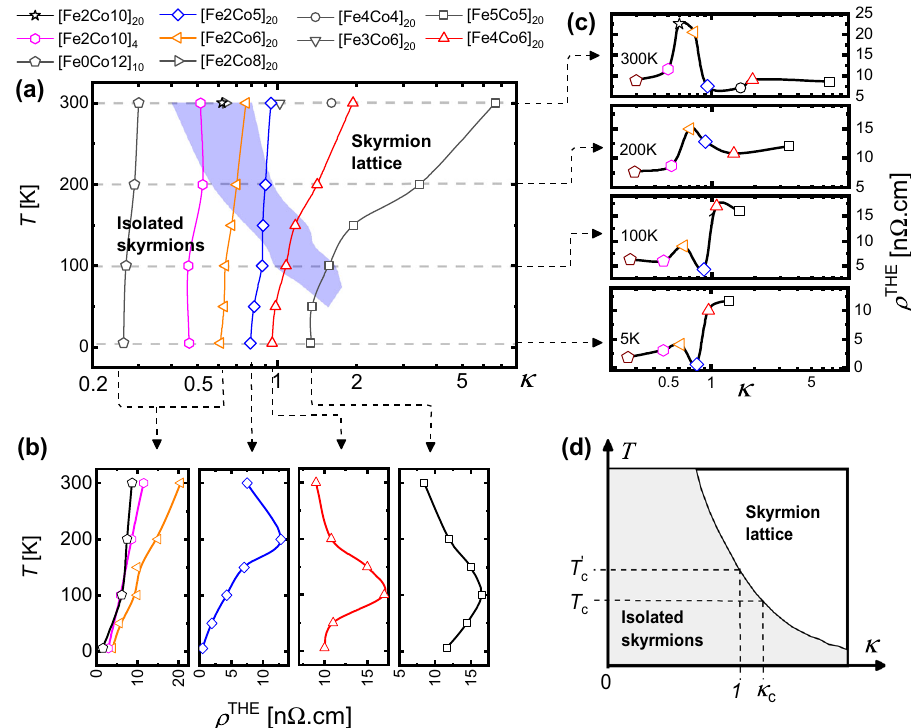
Fig. 2 Evolution of ρ THE across the phase transition between isolated skyrmions and a disordered skyrmion lattice in T − κ space. a Phase diagram of skyrmion con fi gurations in T − κ space obtained by varying T and Fe/Co composition. The shaded area in blue is the transition region from isolated skyrmions to a disordered skyrmion lattice revealed by MFM imaging. The spatial evolution of skyrmion con fi guration is analyzed using Delaunay triangulation: details of the analysis including the nearest-neighbor (NN) coordination number and NN angular orientation can be found in Section 1 of the Supplementary Information 5 . Details of our estimation of the T -dependent κ are presented in Section 2 of the Supplementary Information. b Evolution of ρ THE with ( T , κ ). Arrows with dotted lines point to the speci fi c samples in ( a ) for which ρ THE is studied as a function of T . c Evolution of ρ THE with κ at a fi xed T . Arrows with dotted lines point to the various samples in ( a ) for which ρ THE ( κ ) is studied at a fi xed T . d Schematic T − κ phase diagram illustrating the phase boundary T c ( κ ) and the use of the effective temperature T 0 ¼ T (cid:2) κ to describe the phase transition. The error bars on ρ THE in ( b ) and ( c ) are ≤ 2 n Ω